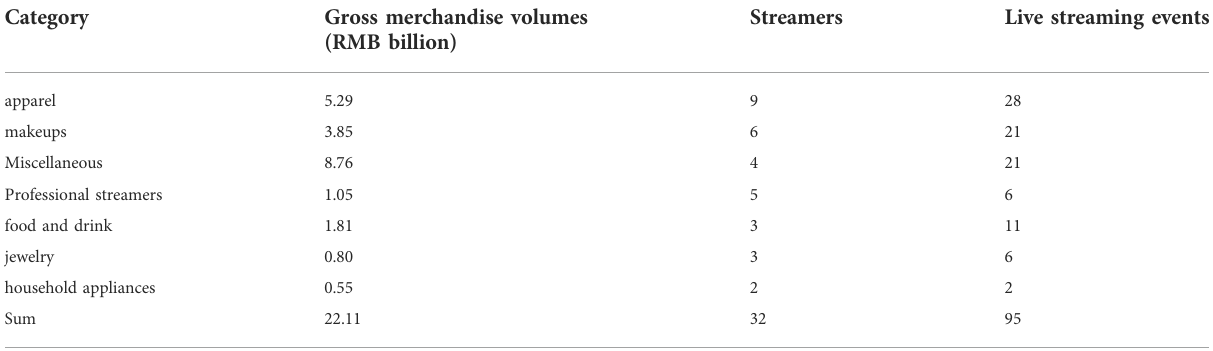
TABLE 2 Category distribution of Kuaishou livestreaming with gross merchandise volumes over RMB 0.1 billion.